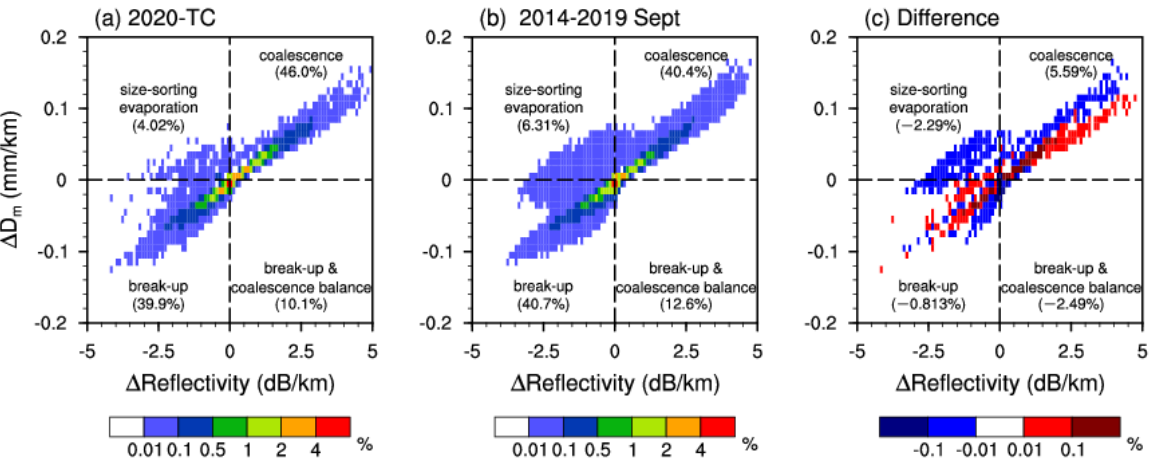
Figure 8. Frequency patterns in two-dimensional space of ∆ D m and ∆ Reflectivity for ( a ) 2020-TC, ( b ) September 2014 – September 2019, and ( c ) their difference (former minus the latter). The text in the figure represents the dominant microphysical processes and proportions in each quadrant.